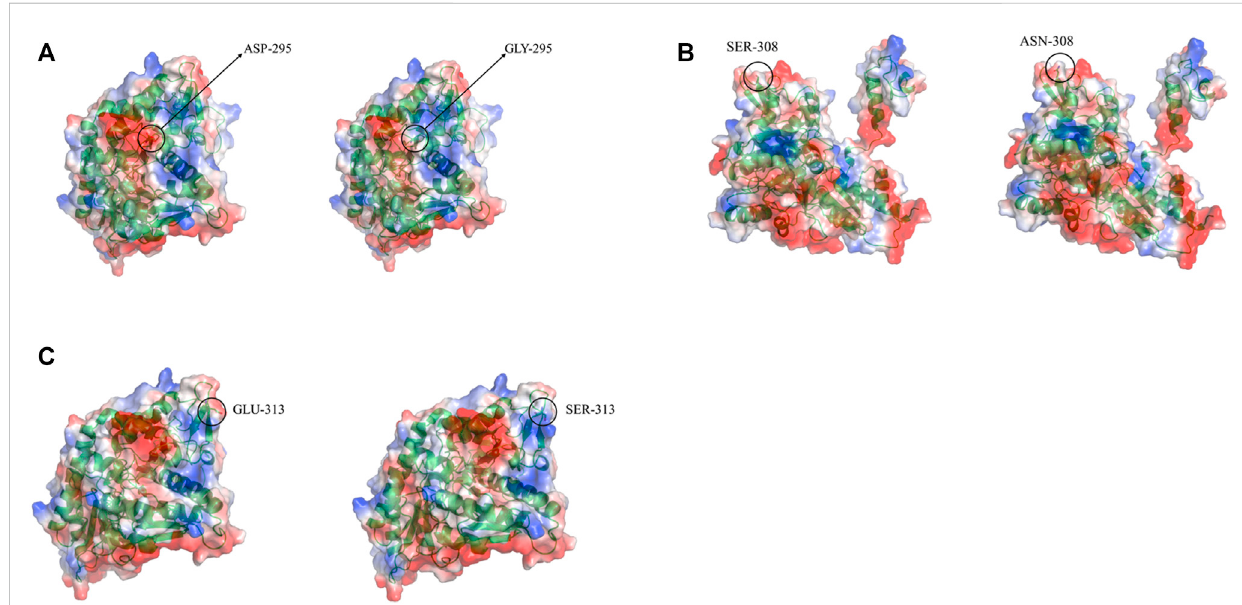
FIGURE 5 Changes in electrostatic potential of mutant sites before and after LpGAD mutation. (A) The change of the electrostatic potential of the amino acid residue at position 295 before and after mutation; (B) The change of the electrostatic potential of the amino acid residue at position 308 before and after